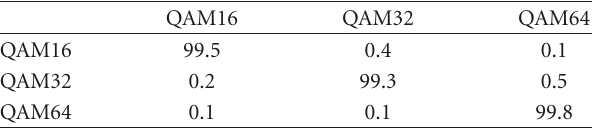
Table 5: Confusion Matrix at SNR = − 6 d B.